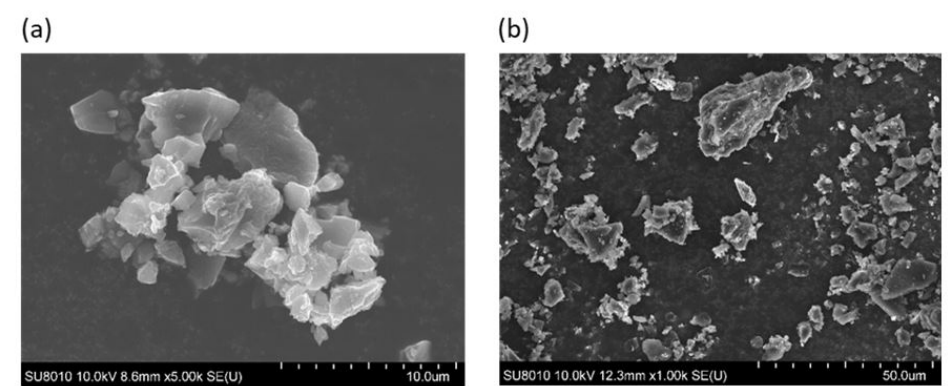
Figure 1. Distribution of particle size of AG Pleisch carbon sorbent before grinding ( a ) and after four hours of grinding in a planetary ball mill, ( b ) and of SAR carbon sorbent after four hours of grinding ( c ).